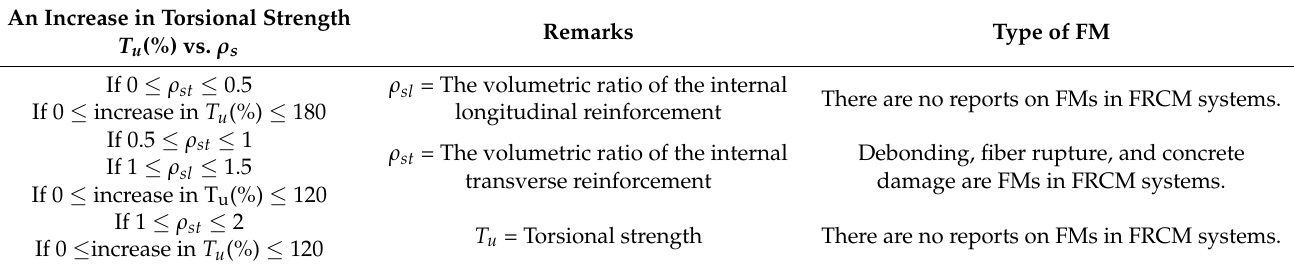
Table 10. An increase in torsional strength T u versus ρ sl and ρ st .